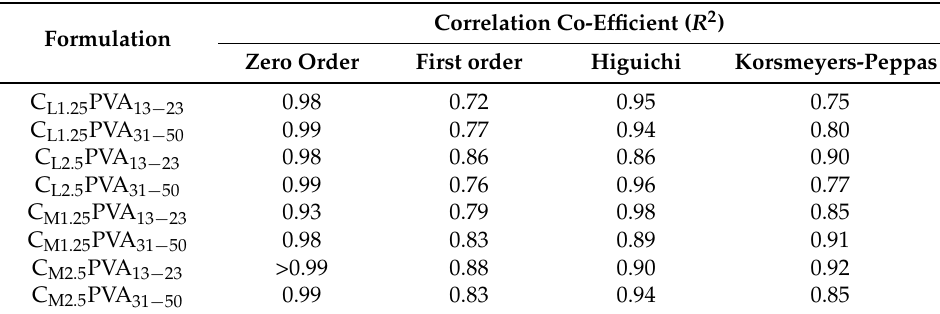
Table 3. Mathematical modelling of monoterpene release from the hydrogel formulations.